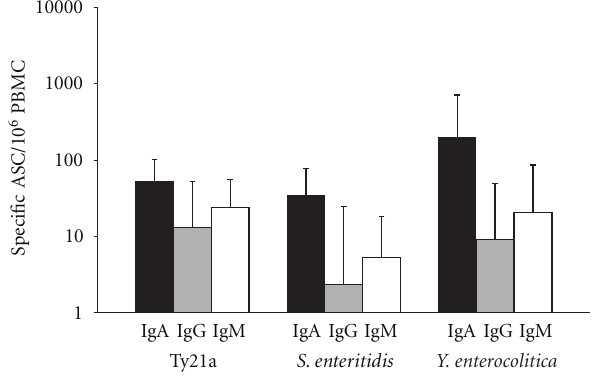
Figure 5: The isotype distribution in the peak of the specific plasmablast response in volunteers vaccinated with the oral live Salmonella typhi Ty21a vaccine ( n = 6) and in patients with gastroenteritis caused by Salmonella enteritidis ( n = 8) or Yersinia enterocolitica ( n = 5). The data are given as geometric means of ASC / 10 6 PBMC ±